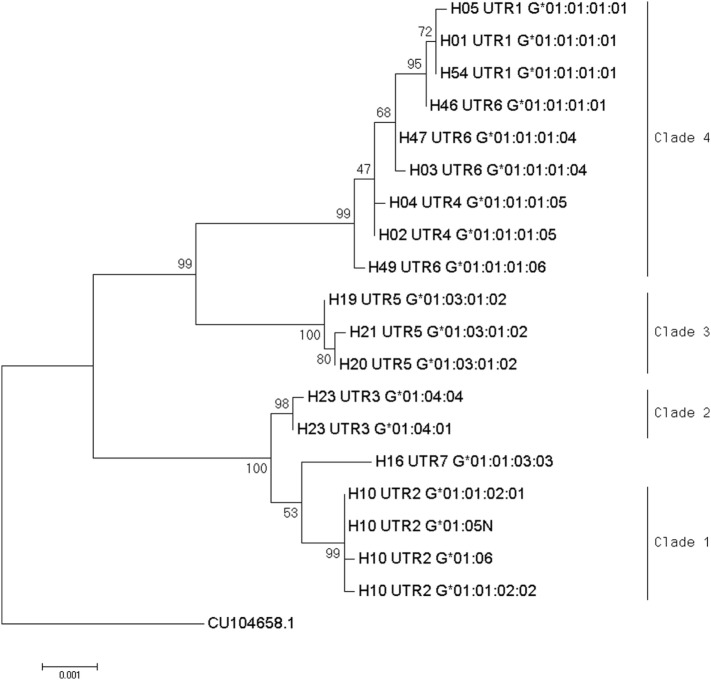
Phylogenetic relationship between human leukocyte antigen-G (HLA-G) allele-haplotype sequences. The phylogenetic tree contains 19 sequences from −1983 to +3447 aligned using the multiple sequence alignment tool MUSCLE in the Molecular Evolutionary Genetics Analysis software version 7.0; sequences were H01-UTR1-G*01:01:01:01, H05-UTR1-G*01:01:01:01, H54-UTR1-G*01:01:01:01, H04-UTR4-G*01:01:01:05, H02-UTR4-G*01:01:01:05, H21-UTR5-G*01:03:01:02, H20-UTR5-G*01:03:01:02, H19-UTR5-G*01:03:01:02, H10-UTR2-G*01:01:02:01, H10-UTR2-G*01:01:02:02, H10-UTR2-G*01:06, H10-UTR2-G*01:05N, H23-UTR3-G*01:04:01, H23-UTR3-G*01:04:04, H16-UTR7G*01:01:03:03, H46-UTR6-G*01:01:01:01, H47-UTR6-G*01:01:01:04, H03-UTR6-G*01:01:01:04, and H49-UTR6-G*01:01:01:06. Evolutionary relationships among HLA-G whole sequences were inferred using the neighbor-joining method with 1,000 replicates. Evolutionary distances were computed using the p-distance method, and units were the number of base differences per site. The percentage of trees in which the associated taxa clustered together is shown next to the branches. The sum of branch length equals 0.01616800 base differences per site. The percentage of replicate trees in which the associated taxa clustered together in the bootstrap test is shown next to the branches. The tree was drawn to scale, with branch lengths in the same units (base differences per site) as the evolutionary distances used to construct the phylogenetic tree. Analysis involved gorilla HLA-G genomic sequence as an outgroup (accession number CU104658.1).